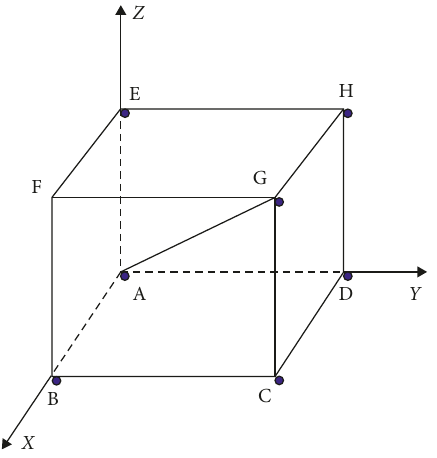
Figure 7: Model of the monitoring